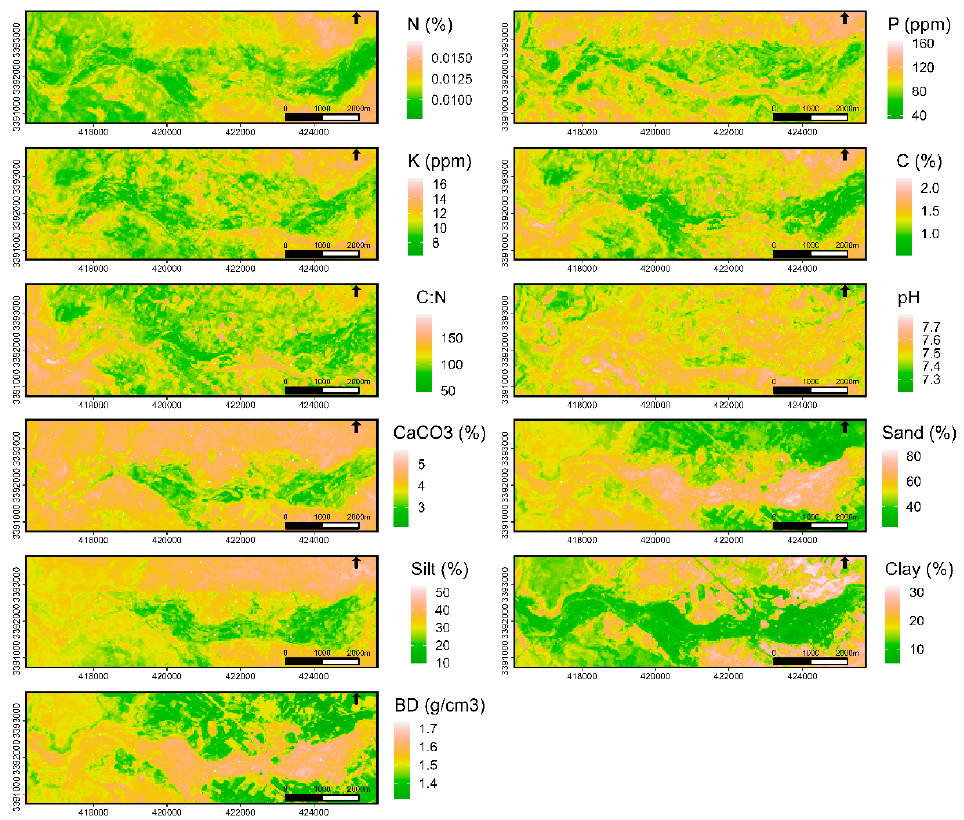
Figure 4. The spatial variability of soil properties in the studied site.